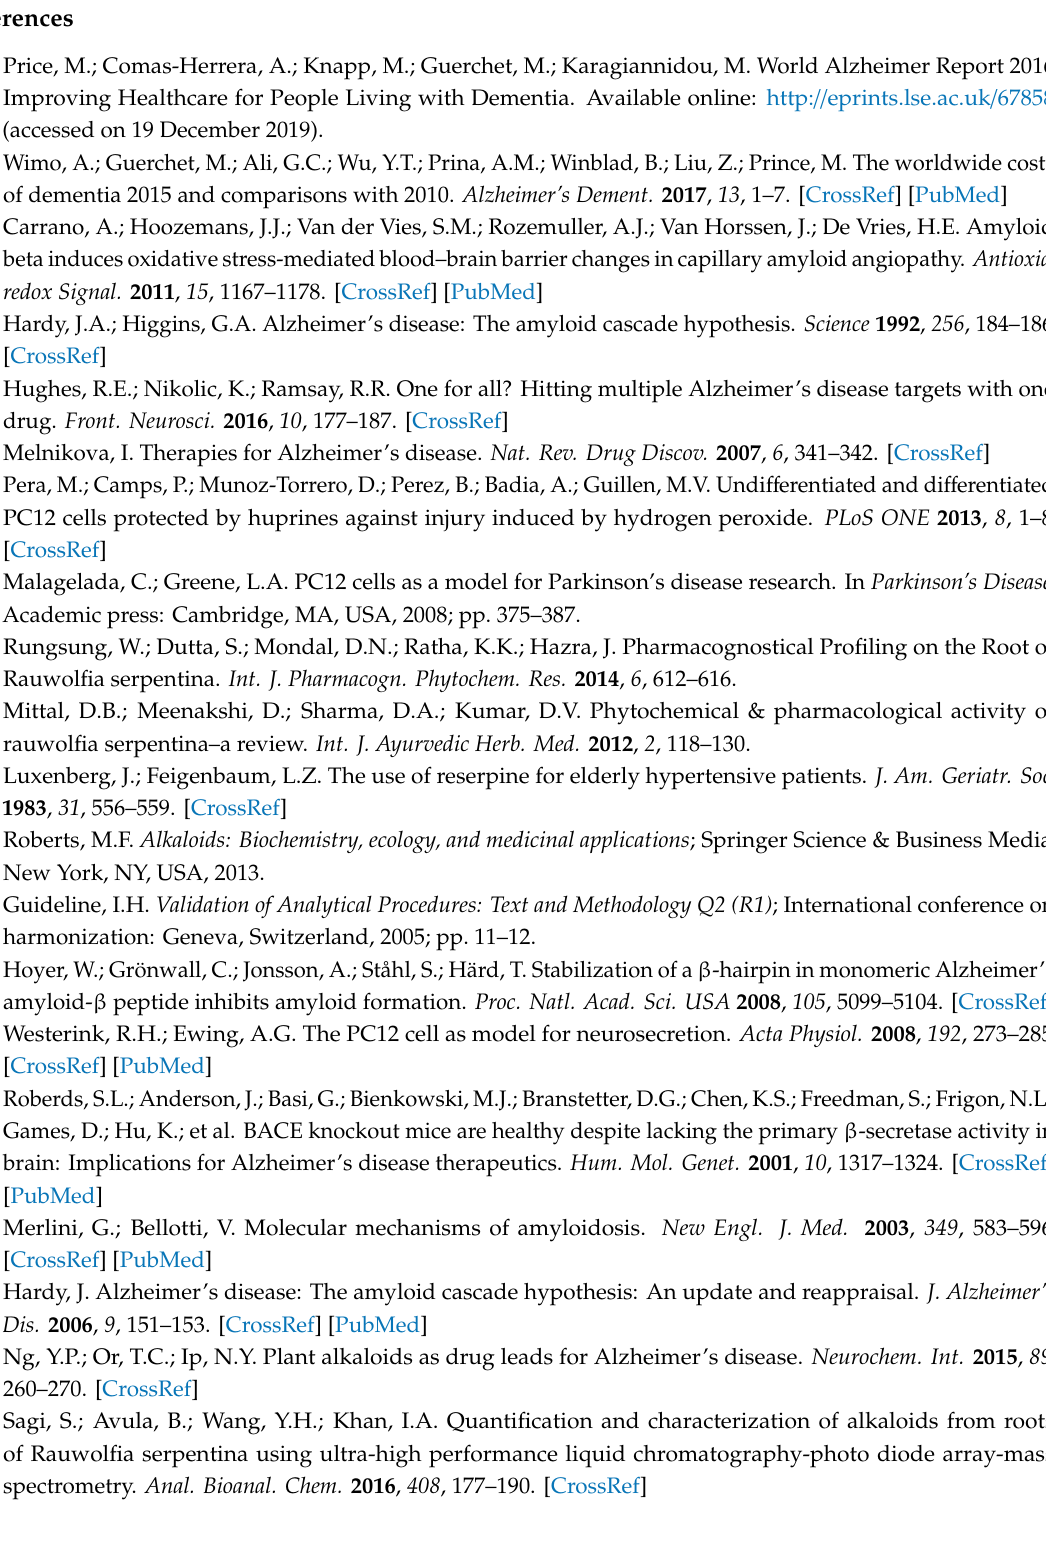
site, LOD—Level of detection, LOQ—Level of quantification, UPLC—Ultra pressure liquid chromatography, QTOF—Quadrupole time of flight, HPLC—High pressure liquid chromatography, ThT—Thioflavin T, CR—Congo Red, CD—Circular